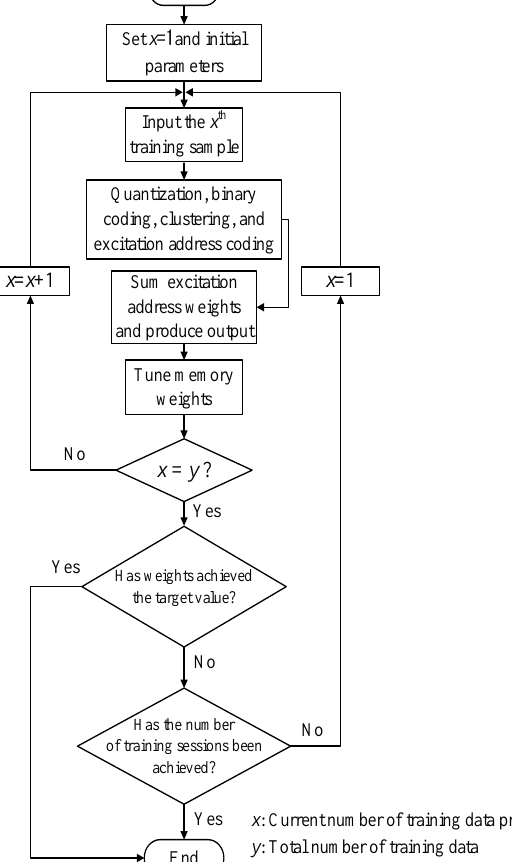
Figure 11. Training flowchart for the CMAC − based fault diagnosis system for inverters.